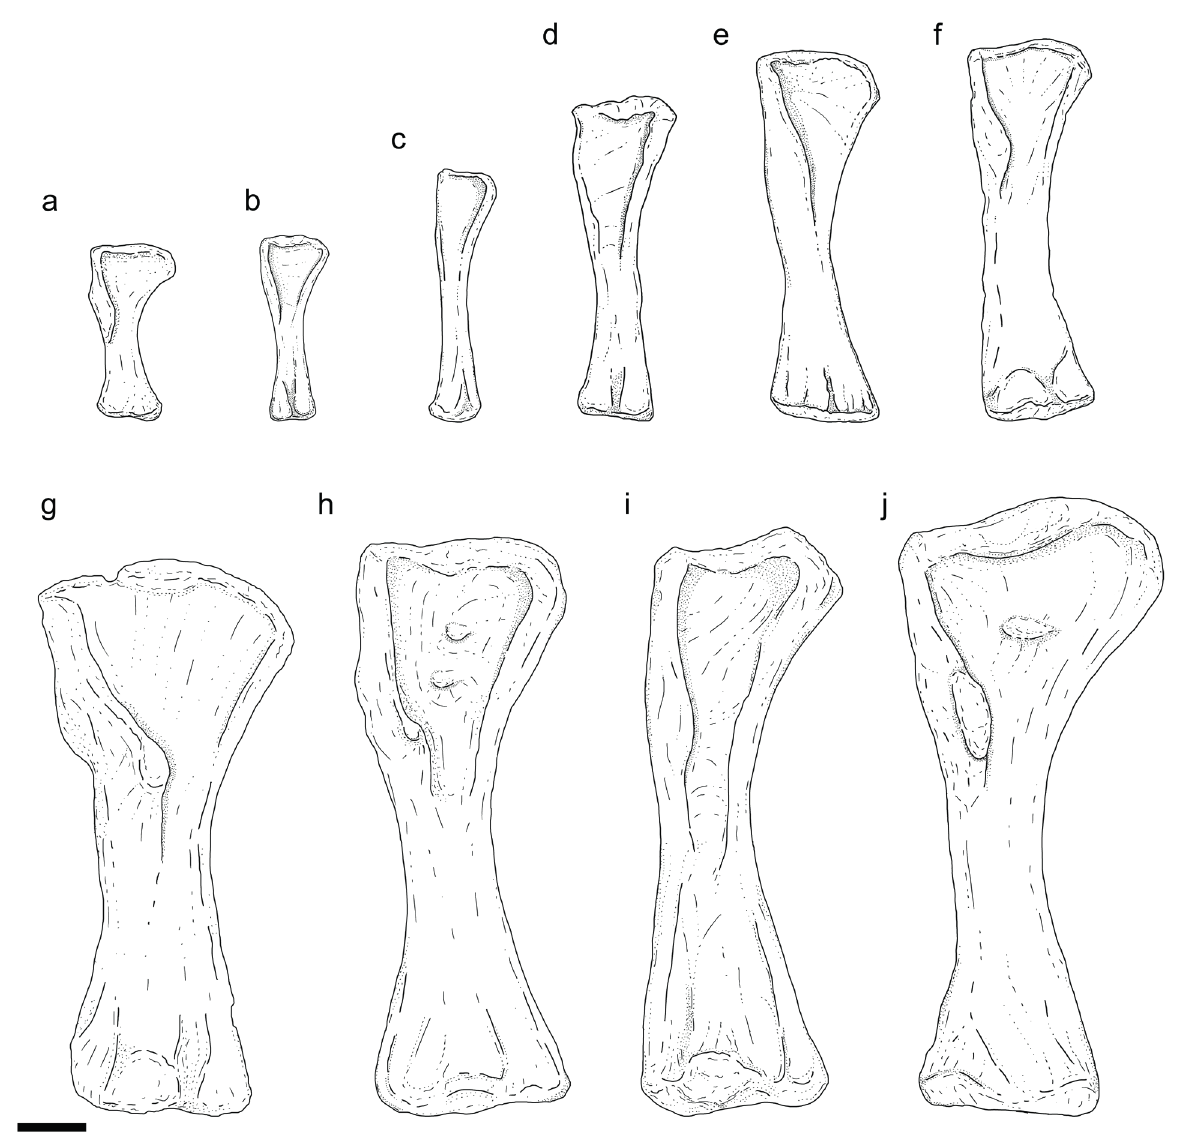
Figure 4 – Morphological and size comparison of titanosaurian right humeri in anterior view. South American (Argentinean) taxa marked with an asterisk. (a) Neuquensaurus australis * (left, reversed), redrawn from Otero (2010), (b) Rapetosaurus krausei (left, reversed), redrawn from Curry rogers (2009), (c) Muyelensaurus pecheni * (left, reversed), redrawn from Calvo et al. (2007c), (d) Narambuenatitan palomoi * (left, reversed), redrawn from Filippi et al. (2011a), (e) Mendozasaurus neguyelap *, redrawn from González riga et al. (2018), (f) Angolatitan adamastor , redrawn from Mateus et al. (2011), (g) Dreadnoughtus schrani * (left, reversed), redrawn from Lacovara et al. (2014), (h) Patagotitan mayorum * (left, reversed), redrawn from Carballido et al. (2017), (i) Paralititan stromeri , redrawn from Smith et al. (2001), (j) Notocolossus gonzalezparejasi *, redrawn from González riga et al. (2016). Scale bar equals 20